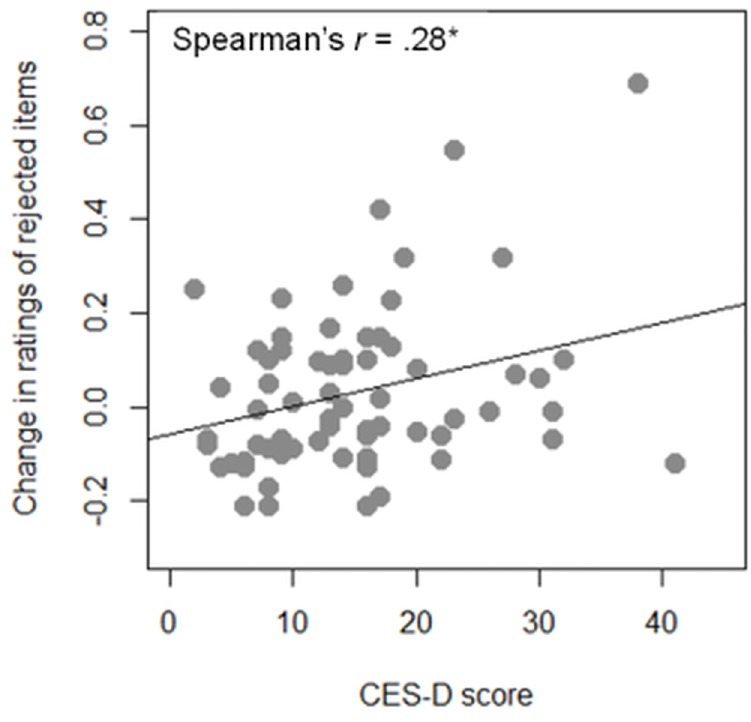
Fig 4. Depressive symptoms and change in preference of rejected items. Scatter plot of depressive symptoms (measured by CES-D) and changein ratings of rejecteditems.